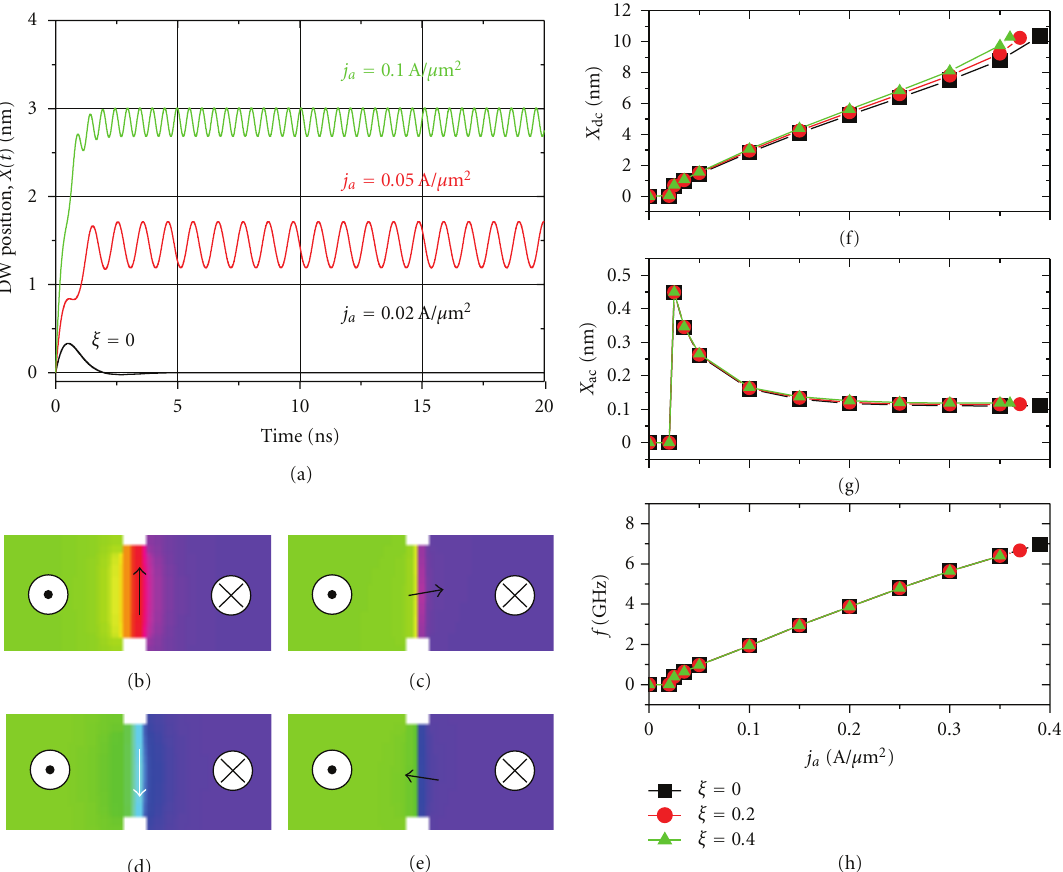
Figure 9: μM results for the DW dynamics under dcs in the pinned regime. The cross-section is L y × L z = 60nm × 3nm, and the dimensions of each rectangular notch are n x = 15nm and n y = 6nm. (a) DW position X ( t ) as a function of time under dcs in the perfect adiabatic case ( ξ = 0). (b)–(e) depict the Bloch and Neel pinned DW configurations under j a = 0 . 05A /μ m 2 . (f) Central DW position ( X dc ), (g) Amplitude ( X ac ), and (h) frequency f of DW oscillations as a function of j a in the pinned regime. (From